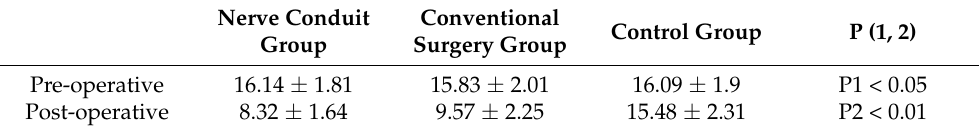
Table 3. Pre- and post-operative TCSS scores in different groups.